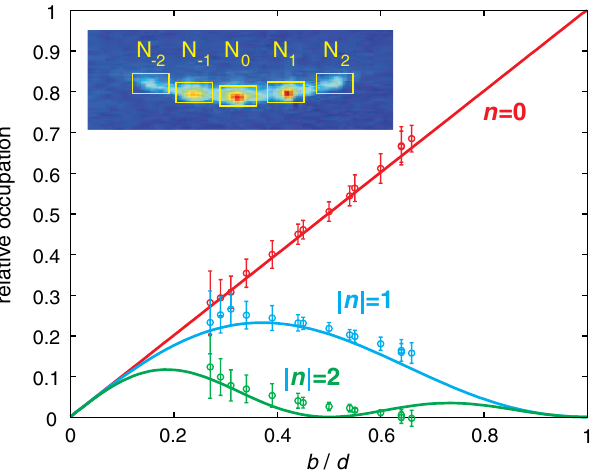
FIG. 4 Comparison between theory and experiment. Width of the reflection zone b=d versus laser power P . Red circles are experimental data points obtained from the fit in Fig. 3. Error bars of the data points are due to the combined statistic and systematic uncertainties in the atom-number measurement. Blue dots show the theoretical values taken from the equipotential lines in Fig. 2 and represent the result of the exact calculation based on Rayleigh decompositions. Black points are the corresponding results based on a Hamaker approach. Green points stem from a simulation of the optical potential alone, neglecting any influence of the Casimir-Polder potential. Error bars of the theoretical points represent the systematic error due to the uncertainty in the laser intensity at the surface Δ I ¼ (cid:1) 5% and the velocity of the atoms Δ v ¼ (cid:1) 0 . 3 cm = s. Please note that the data points are horizon- tally shifted one line width ( ≲ 1 mW) for